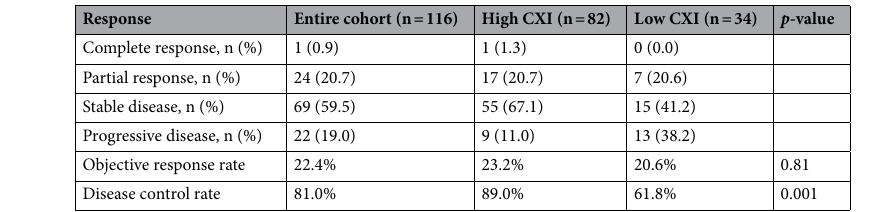
Table 2. Best overall response of lenvatinib according to CXI.